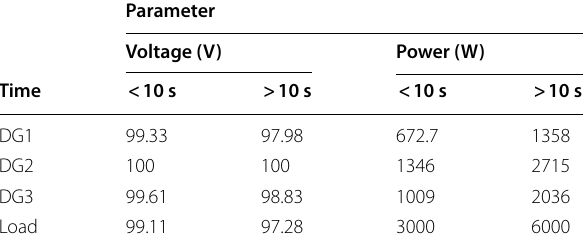
Table 2 System data primary control approach